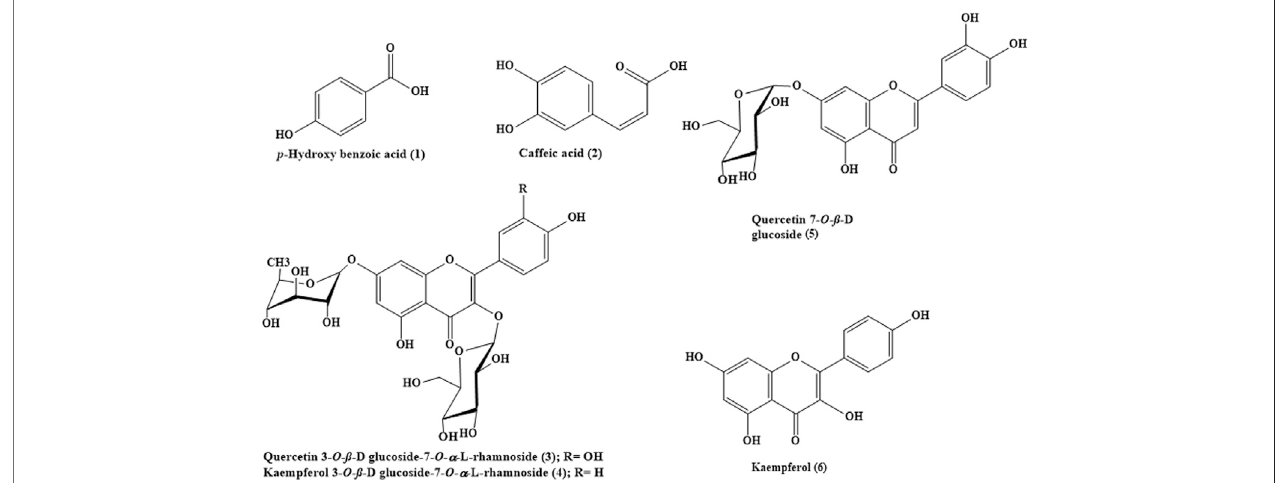
FIGURE 1 | The chemical structures of phenolic compounds isolated from B. indica leaves.